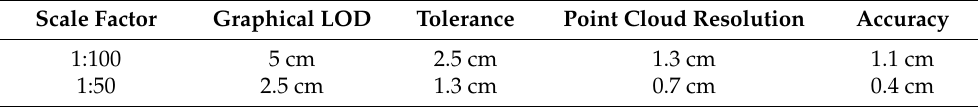
Table 1. Acquisition parameters of the point cloud for the Castle of Torrelobat ó n. Scale